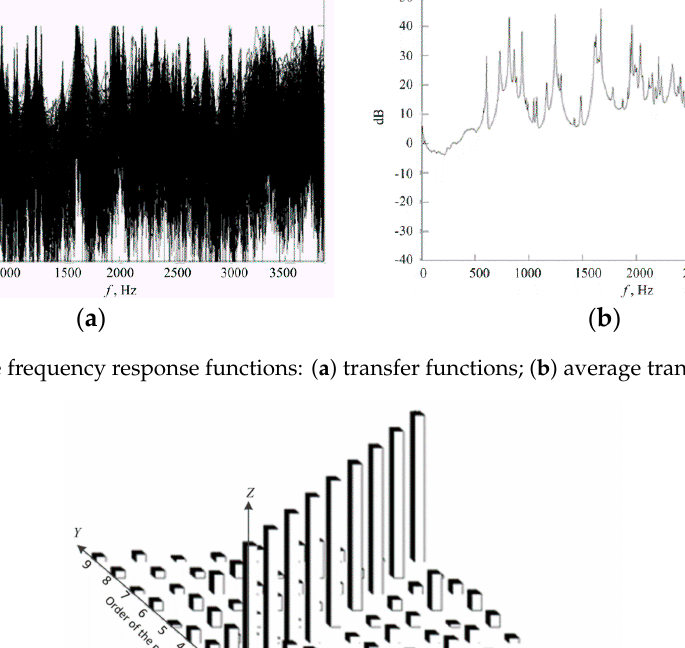
Figure 3. Measurement points.